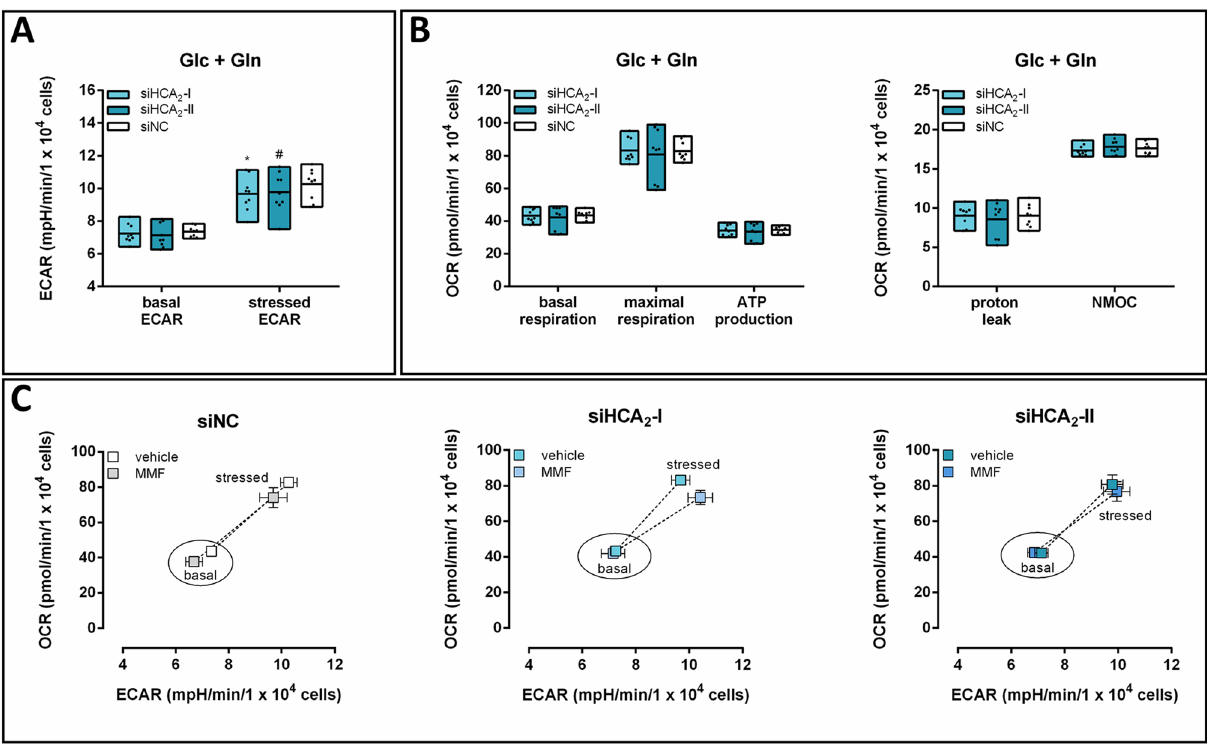
Fig. 2 Reduction in stressed ECAR in siHCA transfected cells in the presence of glucose and glutamine. 24 h after BT-474 cells were trans- 2 fected with siNC or two different siRNAs targeting HCA (siHCA -I; siHCA -II), OCR and ECAR were measured in the presence of glucose and 2 2 2 glutamine (Glc + Gln). Knockdown of HCA caused a decrease in A stressed ECAR, while B mitochondrial respiration and non-mitochondrial 2 oxygen consumption (NMOC) remained unaffected. C The metabolic phenotype and potential (dotted line) of BT-474 cells were determined in the absence and presence of the HCA agonist monomethyl fumarate (MMF). Stimulation with MMF caused an HCA 2 a less energetic phenotype. Data are shown as floating bars (min to max; A , B ) or mean ± SEM ( C ) of three time points of three independ- ent experiments, each carried out in six technical replicates. Statistical analyses were performed using repeated measures one-way ANOVA. # P ≤ 0.1; *P ≤